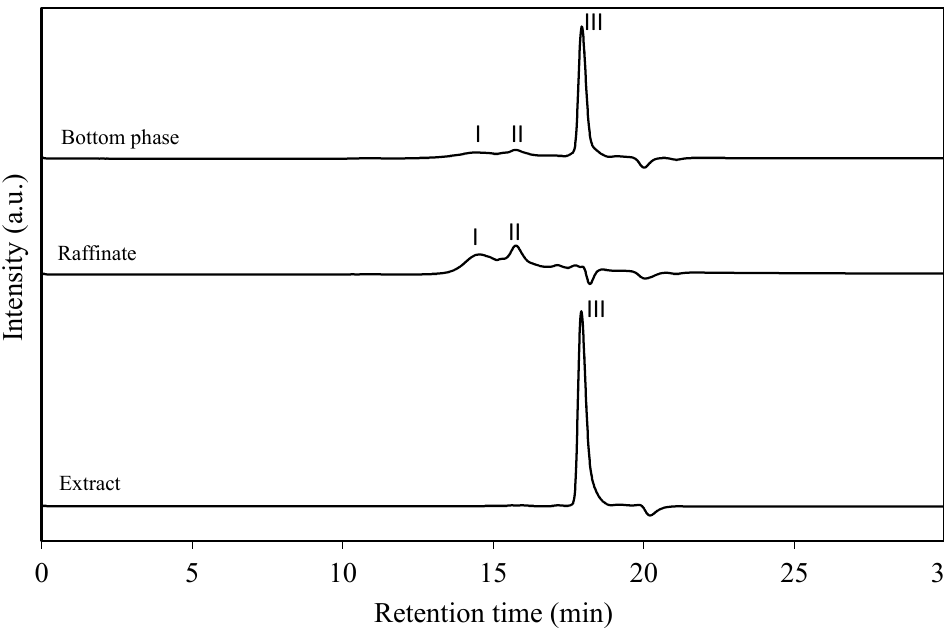
Figure 12. GPC chromatograms of the BP and the raffinate and extract after distillation. Peaks I = rigid polyether polyol; Peak II = reaction by-products; Peak III = Crude glycerol.